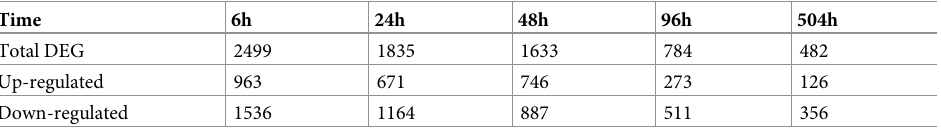
Table 1. Temporal changes in the number of differentially expressed genes (DEGs) in poplar roots in response to PEG-induced drought stress. Time 6h 24h 48h 96h 504h Total DEG 2499 1835 1633 784 482 Up-regulated 963 671 746 273 126 Down-regulated 1536 1164 887 511 356 Complete list of the genes and their expression values are provided in Data